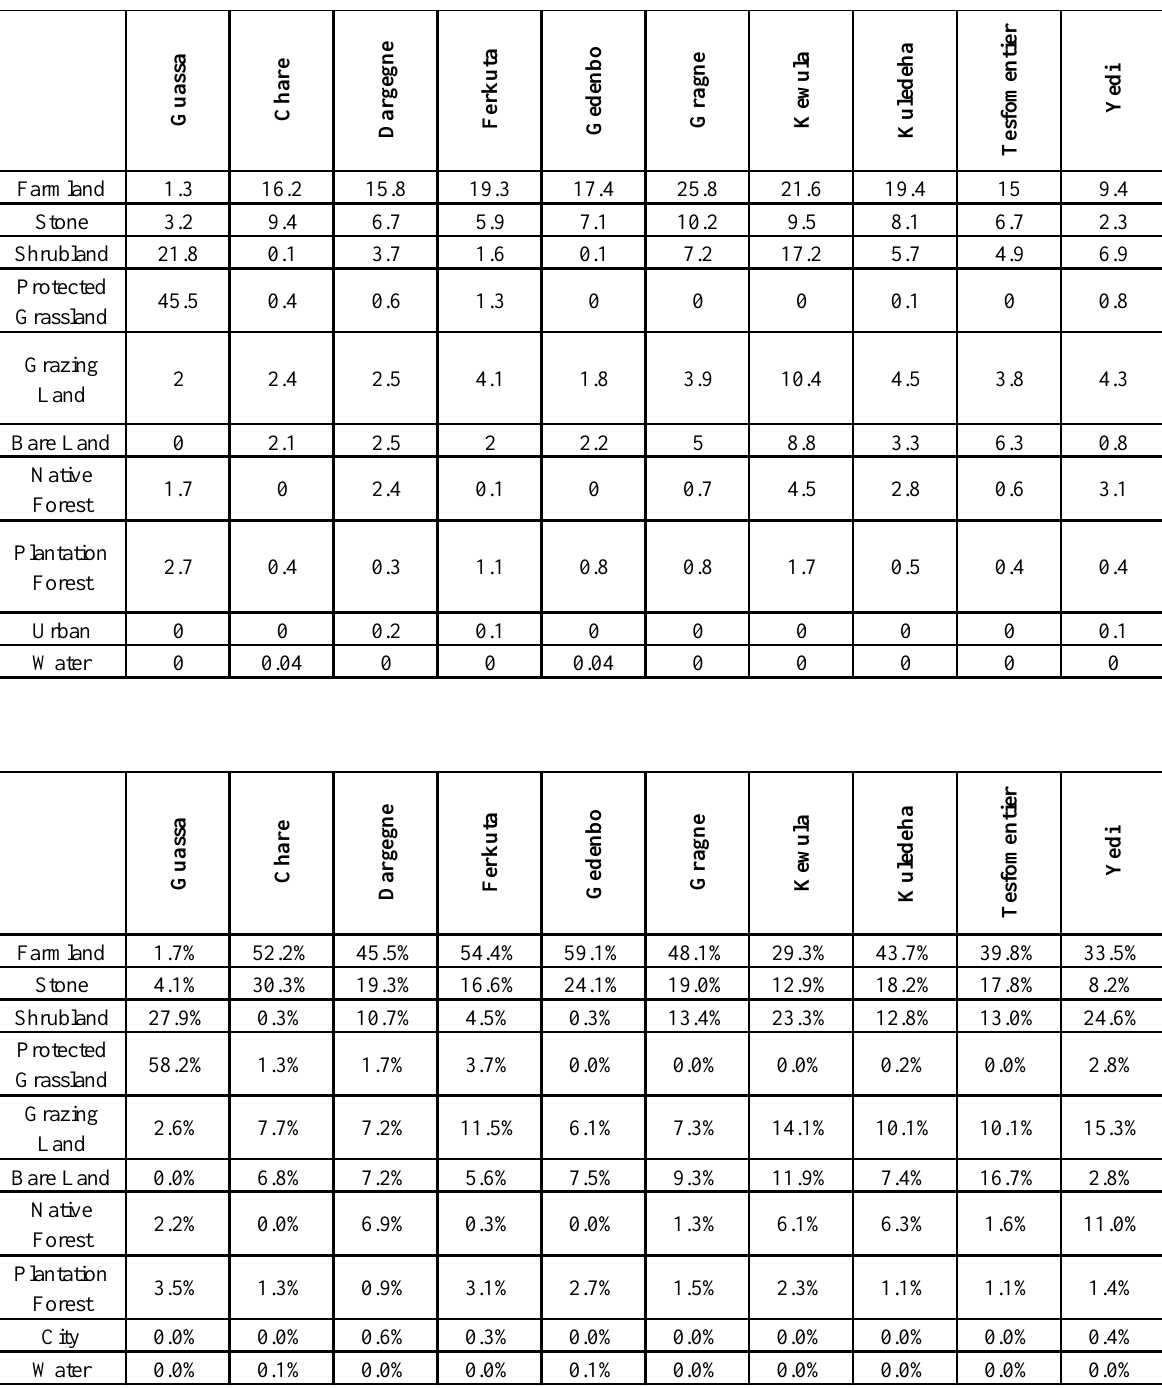
Table A1.2. Top panel shows square kilometers of each land class, separated according to kebele and the Guassa area. Bottom panel shows the percent of land area occupied by each land class for each kebele and the Guassa